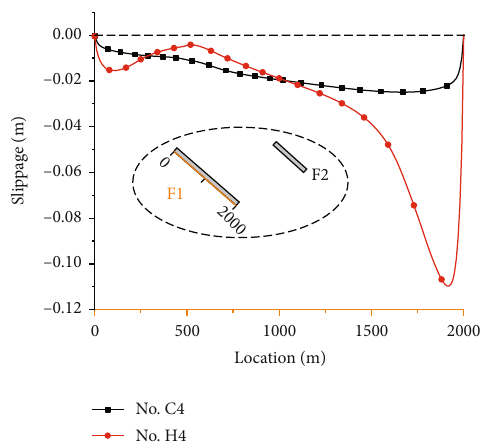
Figure 13: The fault slippage of F1 according to di ff erent fracturing regions (No. C4 and No. H4).